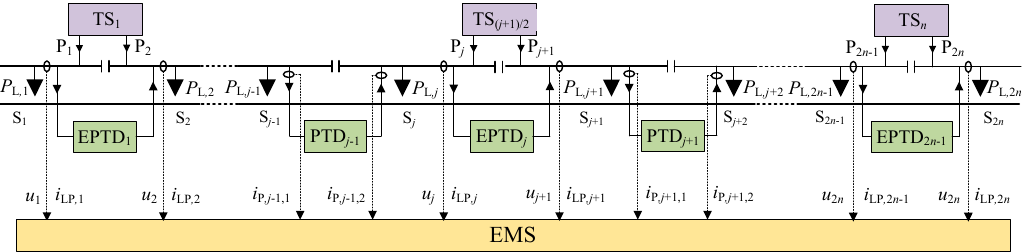
Figure 12. The data information needed to be detected in centralized control.